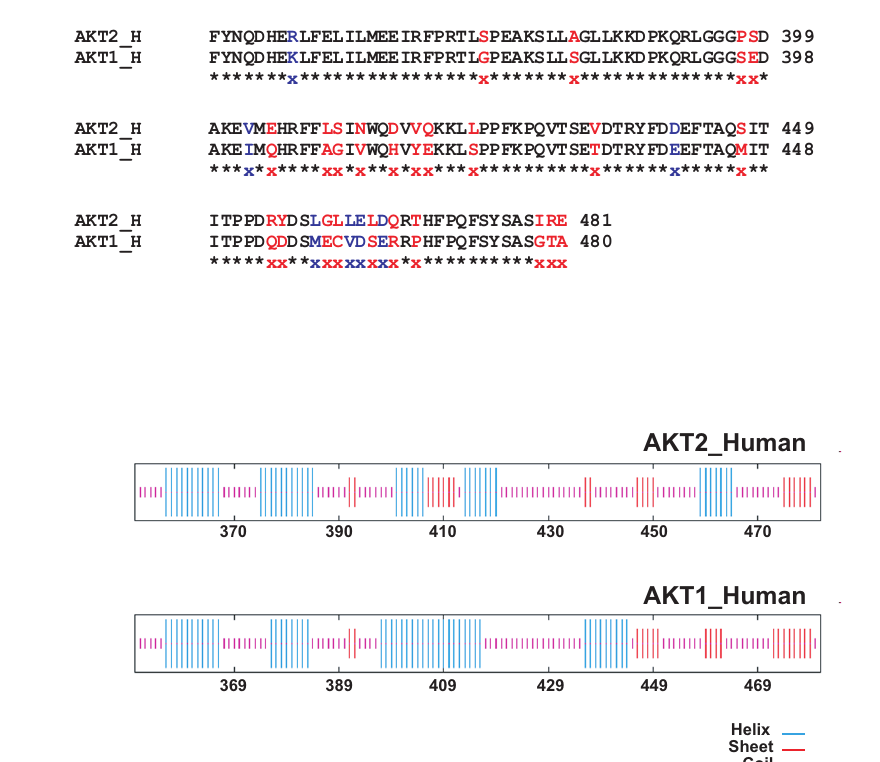
Figure 5. Sequence homology and secondary structure prediction of human Akt1 and Akt2. A. Sequence alignment for the last 130 amino acids of human Akt1 and Akt2. Different residues are shown in red and similar residues are shown in blue. B. Secondary structure prediction for the last 130 amino acids of human Akt1 and Akt2 using GOR4 shared software from PBIL, France (http://npsa-pbil.ibcp.fr/cgi-bin/npsa_automat.